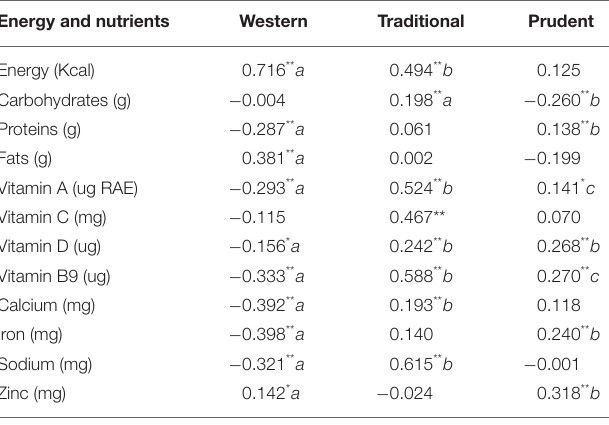
TABLE 3 | Association of energy, energy adjusted macro- and micro nutrients with the derived patterns in the study population ( n = 194) e . Energy and